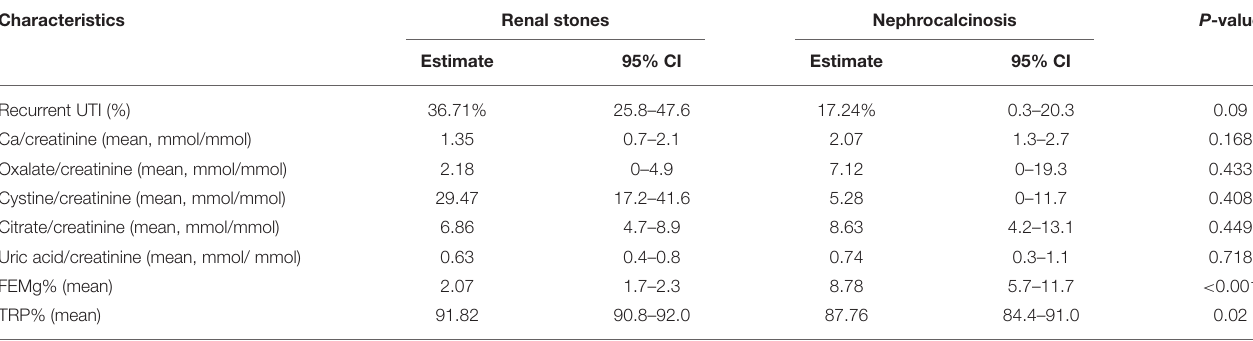
TABLE 3 | Urine chemistry results among patients with nephrolithiasis/urolithiasis (renal stones) and nephrocalcinosis. Characteristics